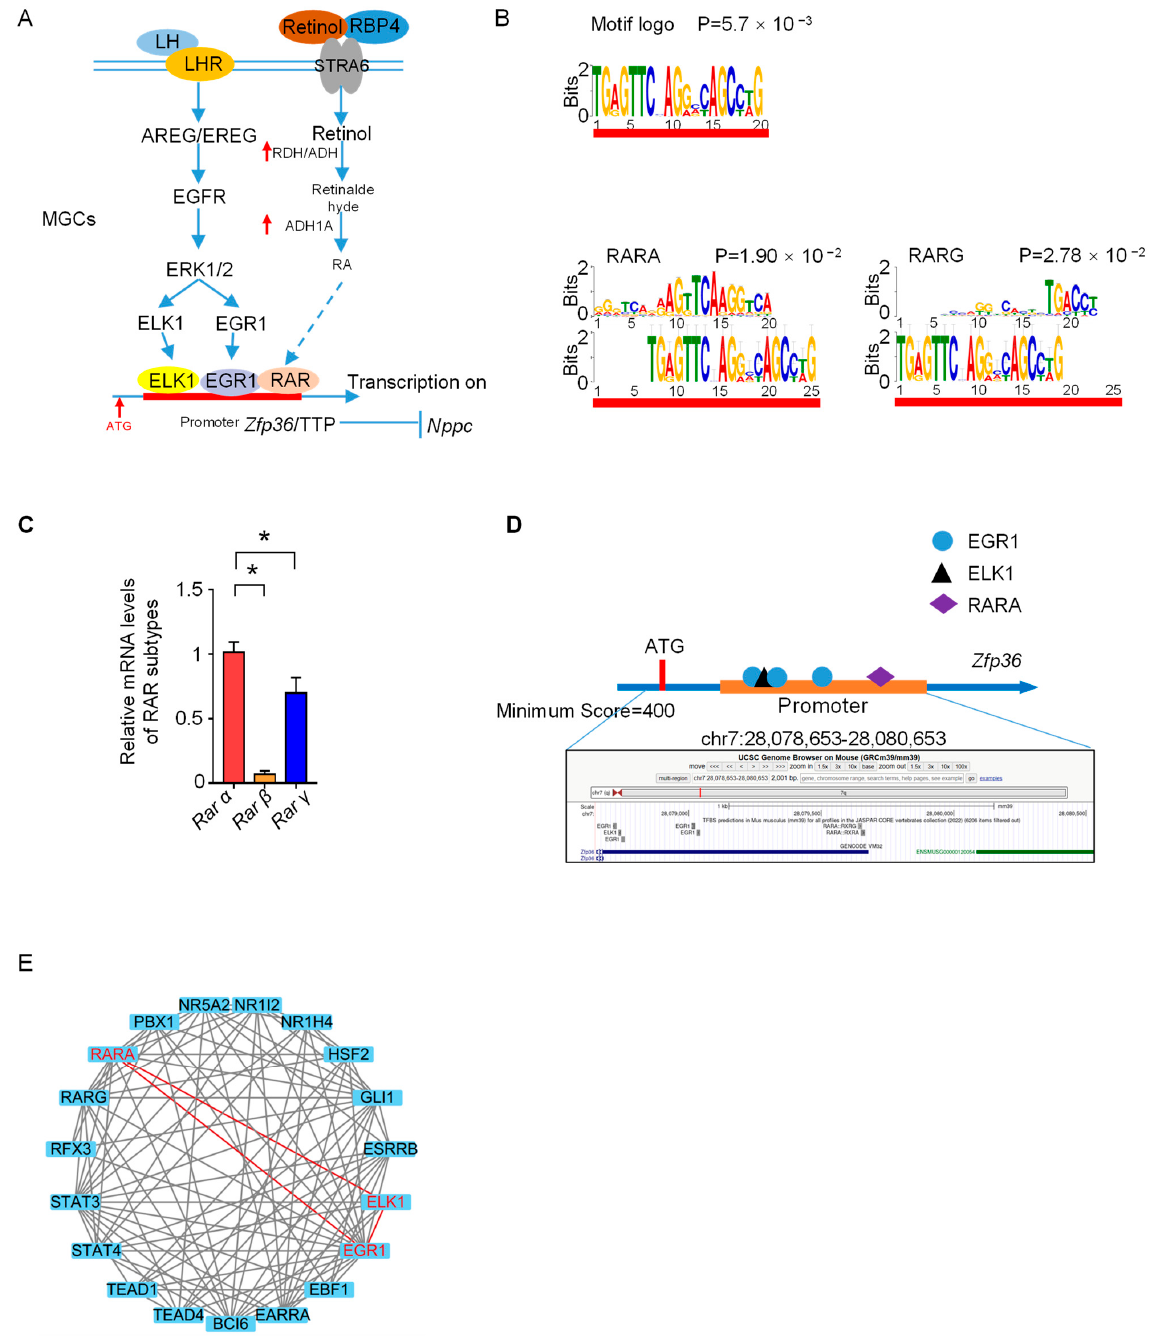
Figure 4. RAR is a potential transcription factor of Zfp36 . ( A ) Schematic illustration of proposed parallel pathways that underlie the Zfp36 upregulation in MGCs in response to LH surge. ( B ) The most significant motifs based on comprehensive motif analysis on sequences located in the promoter regions of Zfp36 using MEME (v5.5.1). The identified motif was compared against a database of known mouse motifs named HOCOMOCO Mouse (v11 Core). The RAR-related DNA binding motifs were: RARA and RARG. ( C ) The relative mRNA levels of RAR subtypes in preovulatory MGCs. * p < 0.05. ( D ) Transcription factors EGR1 and ELK1 were predicted by the JASPAR2022 TFBS mm39 collection, which represented separate tracks in mouse genome assembly chr7:28,078,653-28,080,653. ( E ) STRING Protein-Protein Interaction (PPI) analysis of the transcription factors predicted by the MEME (v5.5.1). Red lines showed the interaction between the EGR1, ELK1 and RARA.